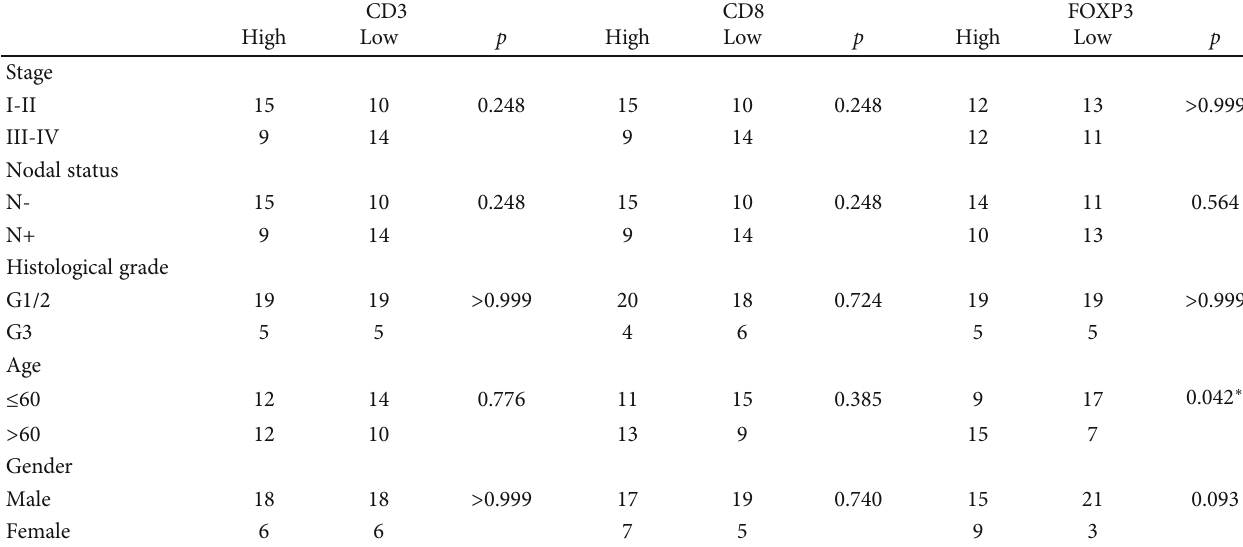
Table 3: Clinicopathological characteristics and TIL markers in ESCC.